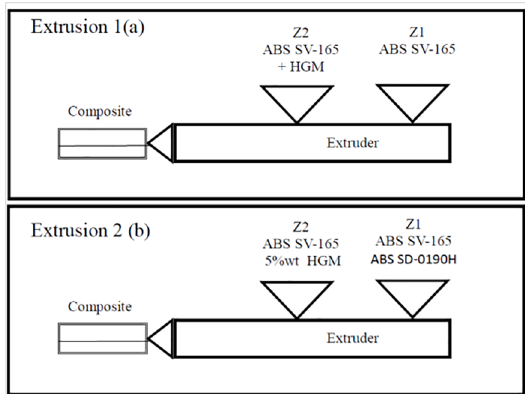
Figure 1. HGM incorporation at the central extruder zone with 5.0 wt.% of ABS (a); and incorporation of high impact ABS at the feeding zone (b).